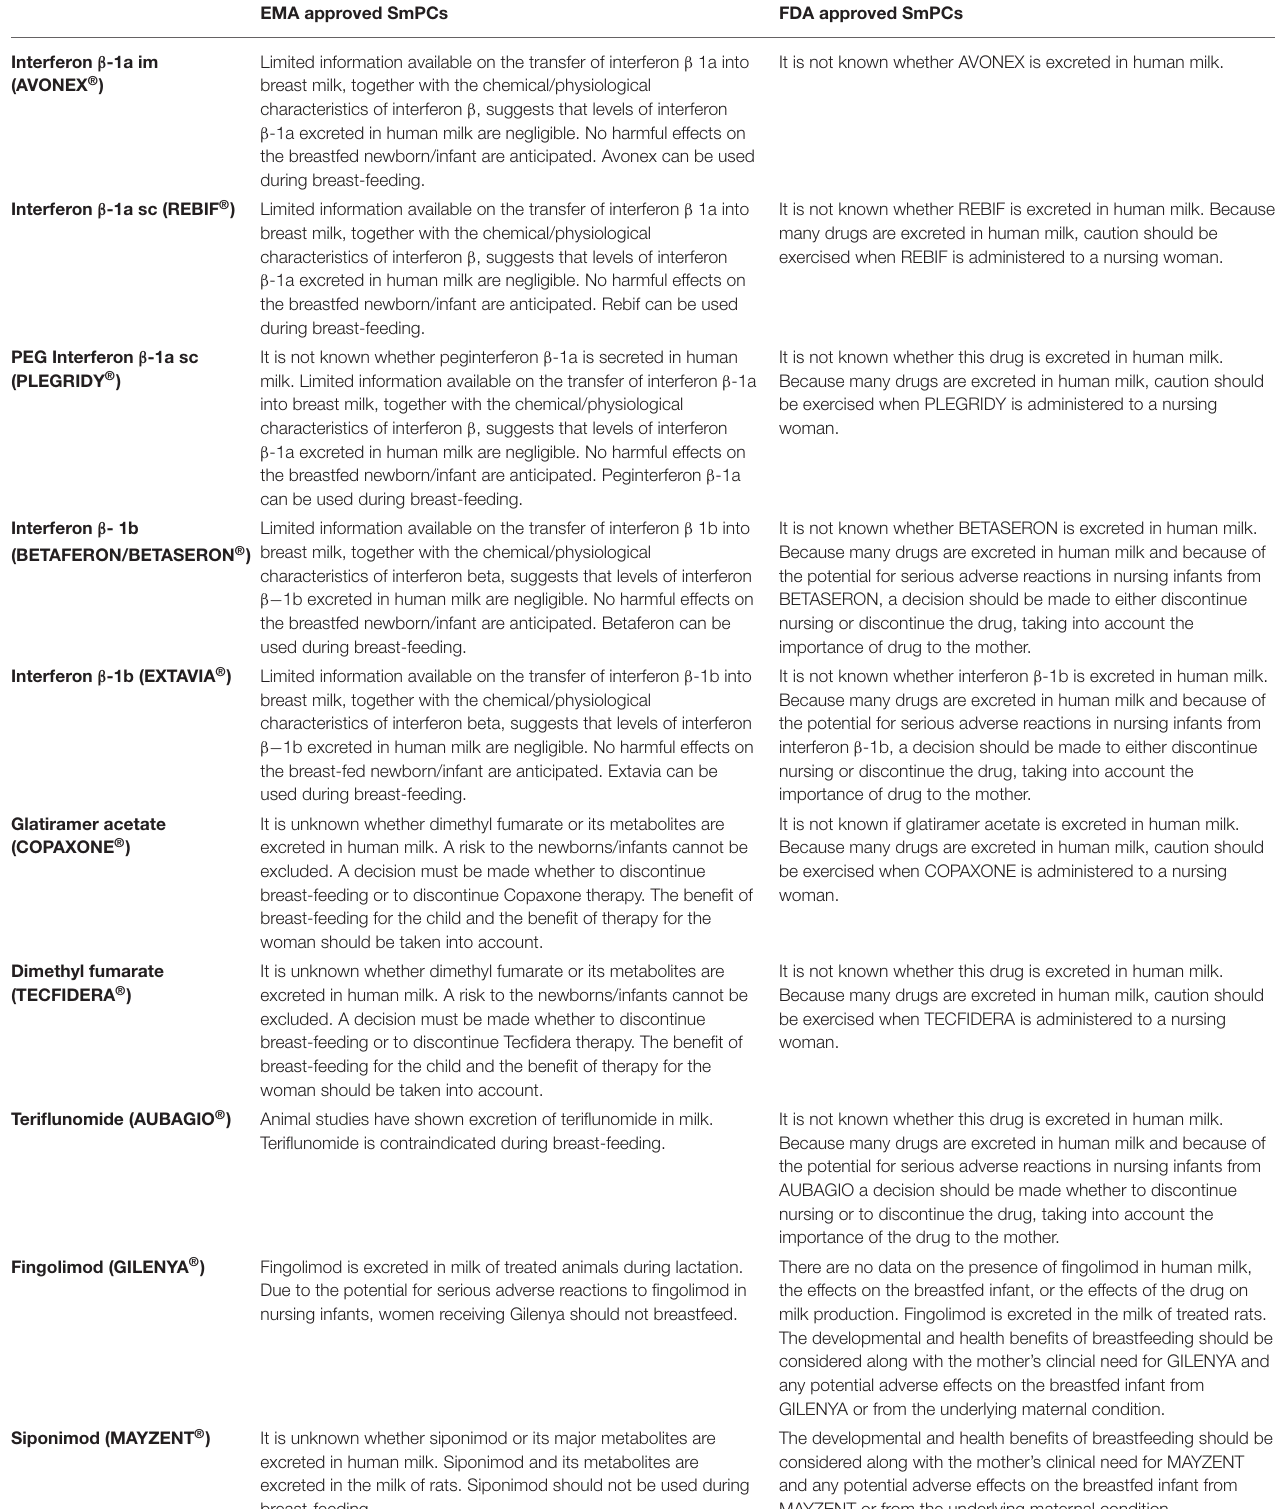
TABLE 1 | DMDs: EMA and FDA SmPCs focusing on breastfeeding